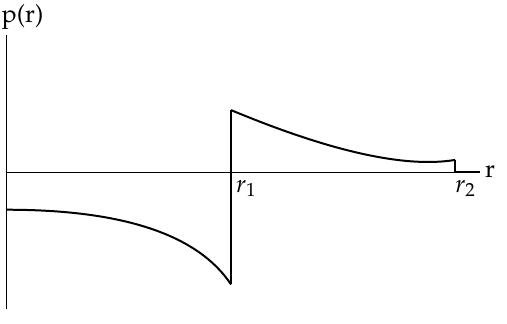
Figure 2. Solution p(r) from Equation